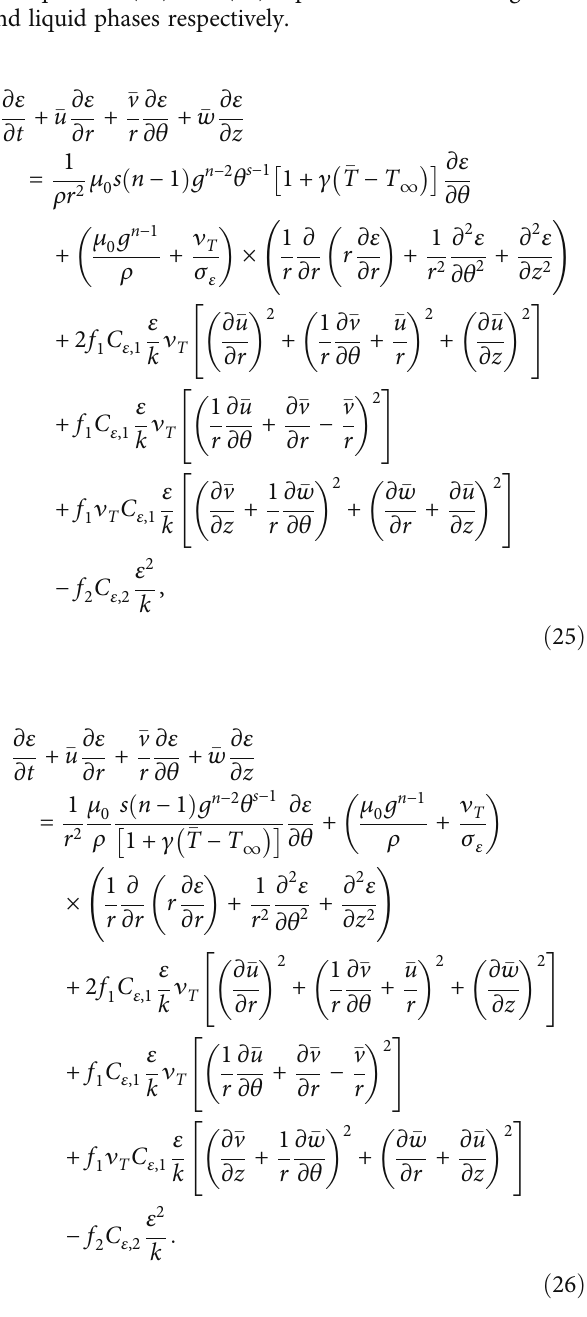
The relationship between dissipation( ε ),